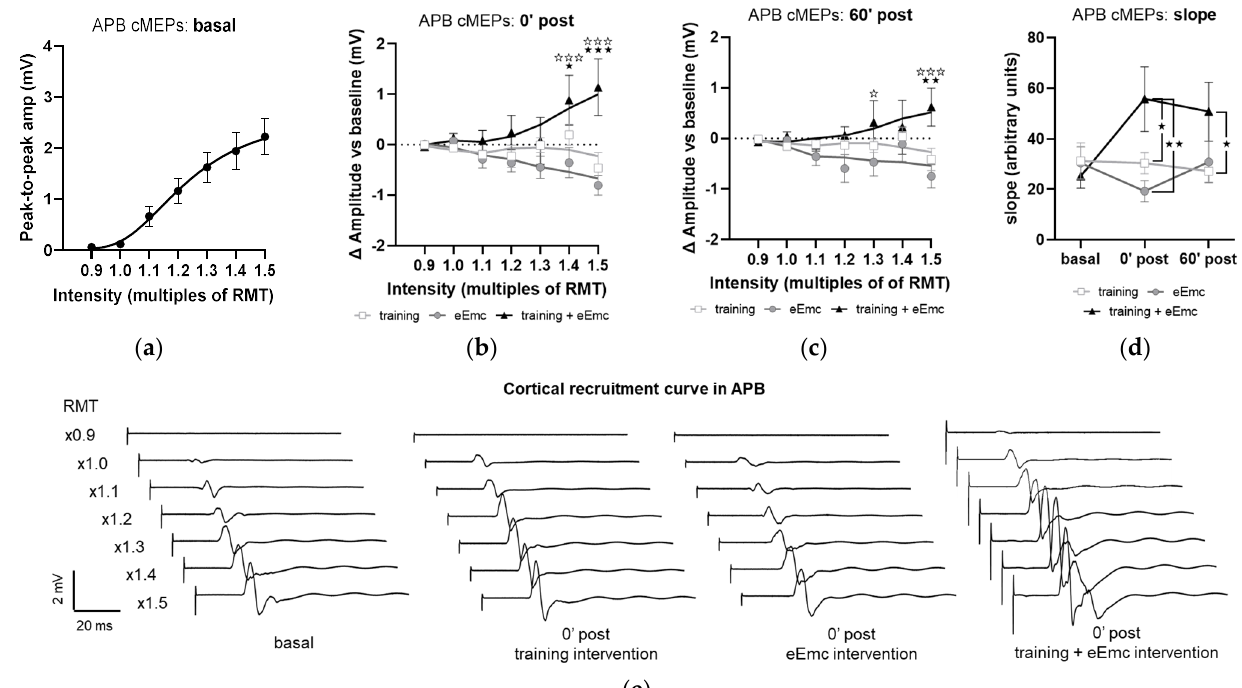
Figure 6. Effect of interventions on cortical recruitment curve. ( a ) Pooled APB recruitment curves obtained at baseline for each subject and intervention. ( b,c ) Increase or decrease (in millivolt (mV); indicated as Δ) in APB recruitment curves with respect to baseline at 0′ ( b ) and 60′ ( c ) post intervention. p < 0.05, p < 0.01, p < 0.001 training vs. training + eEmc; p < 0.05, p < 0.001 eEmc vs. training + eEmc. ( d ) Slope of APB cMEP recruitment curves. Indicated slopes correspond to the slope of the linear regression line through stimulation intensities (in %RMT) and cMEP values (in mV), multiplied ×1000 to facilitate data visualization. p < 0.05, p < 0.01, between interventions at 0′ post and 60′ post. ( e ) Representative APB muscle recording (obtained from subject #1) corresponding to recruitment curve assessment at basal (three conditions averaged) and 0′ post each intervention. APB, abductor pollicis brevis; RMT, resting motor threshold; cMEPs, cortically-induced motor evoked potentials.